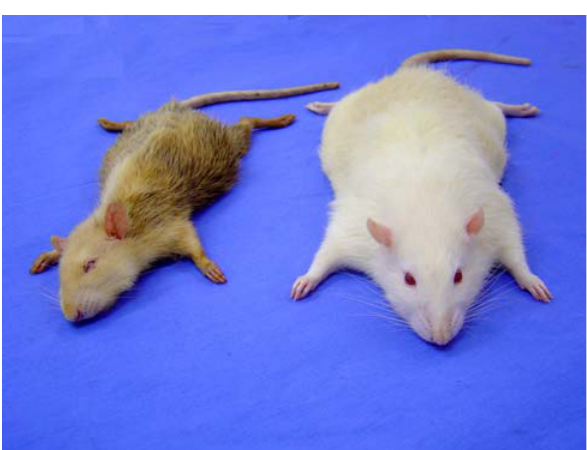
FIGURA 1 - Ilustração de dois ratos, de mesma idade (12m). Note a debilidade, caquexia e alteração da pelagem de um rato diabético sem tratamento (esquerda), quando comparado com o vigor físico de um rato normal